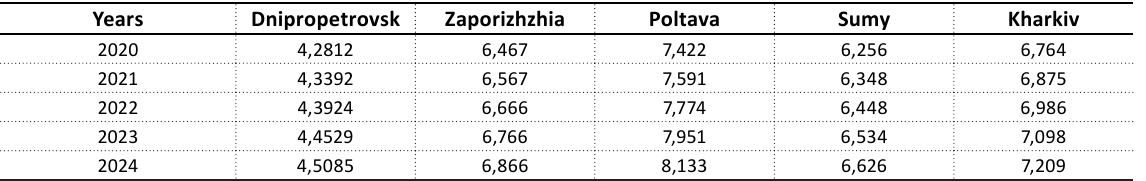
Table 6. Predictions of the generalized indicator of the level of socio-ecological and economic development of